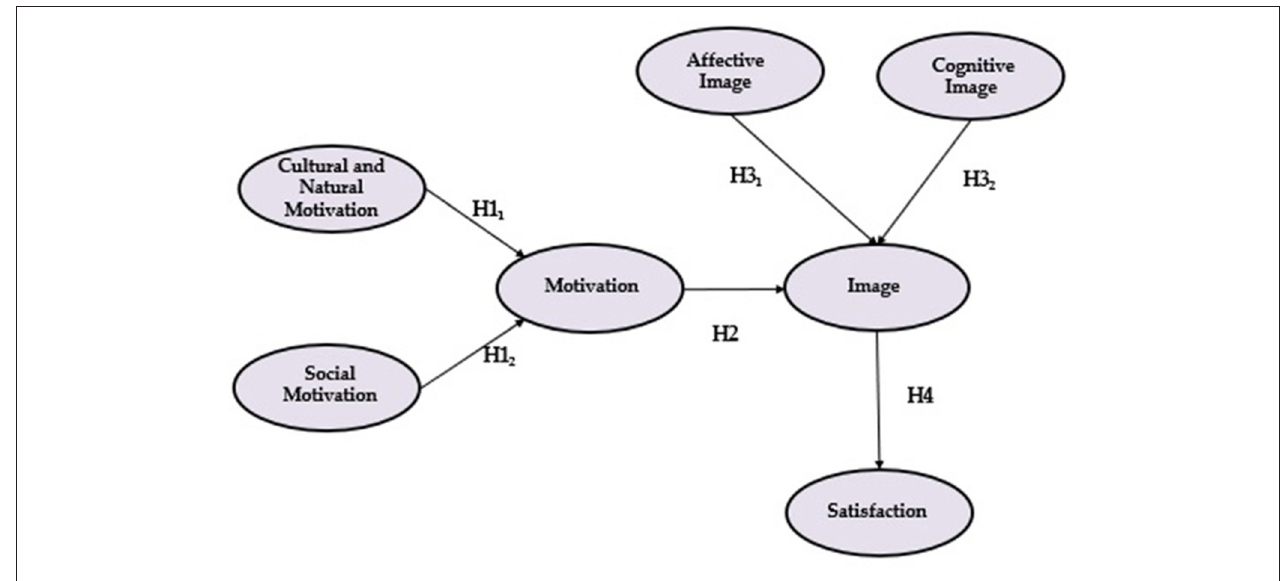
FIGURE 1 | Proposed theorical